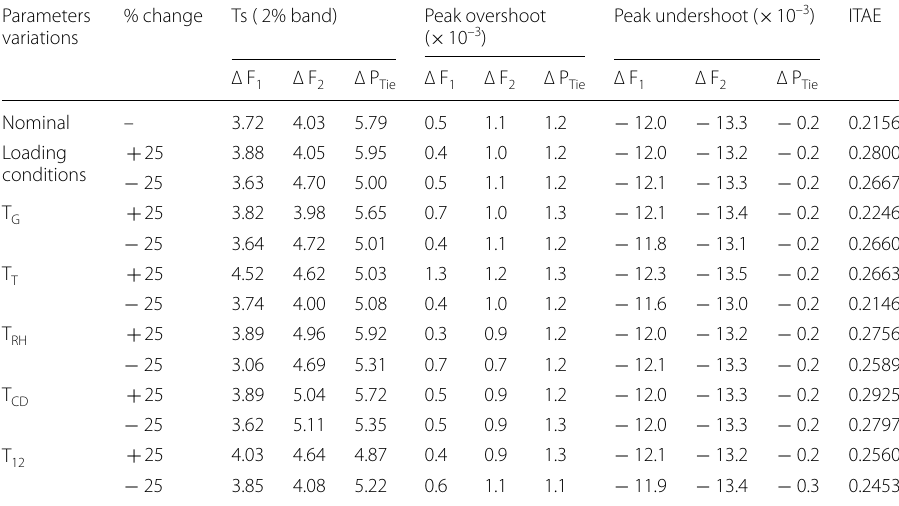
Table 6 Sensitivity analysis with proposed hybrid DE-PS optimized FOPID controller in parallel AC-DC